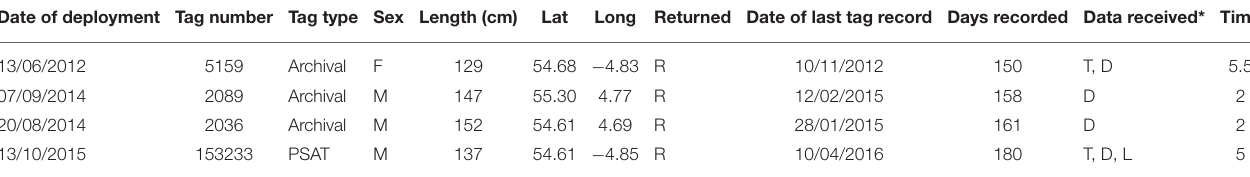
TABLE 2 | Details of tope tagged with tags from which data were recovered. Date of deployment Tag number Tag type Sex Length (cm)